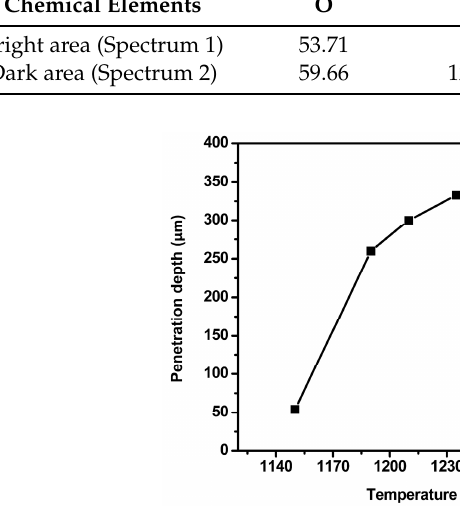
Figure 3. Penetration depths of Fe 2 SiO 4 .